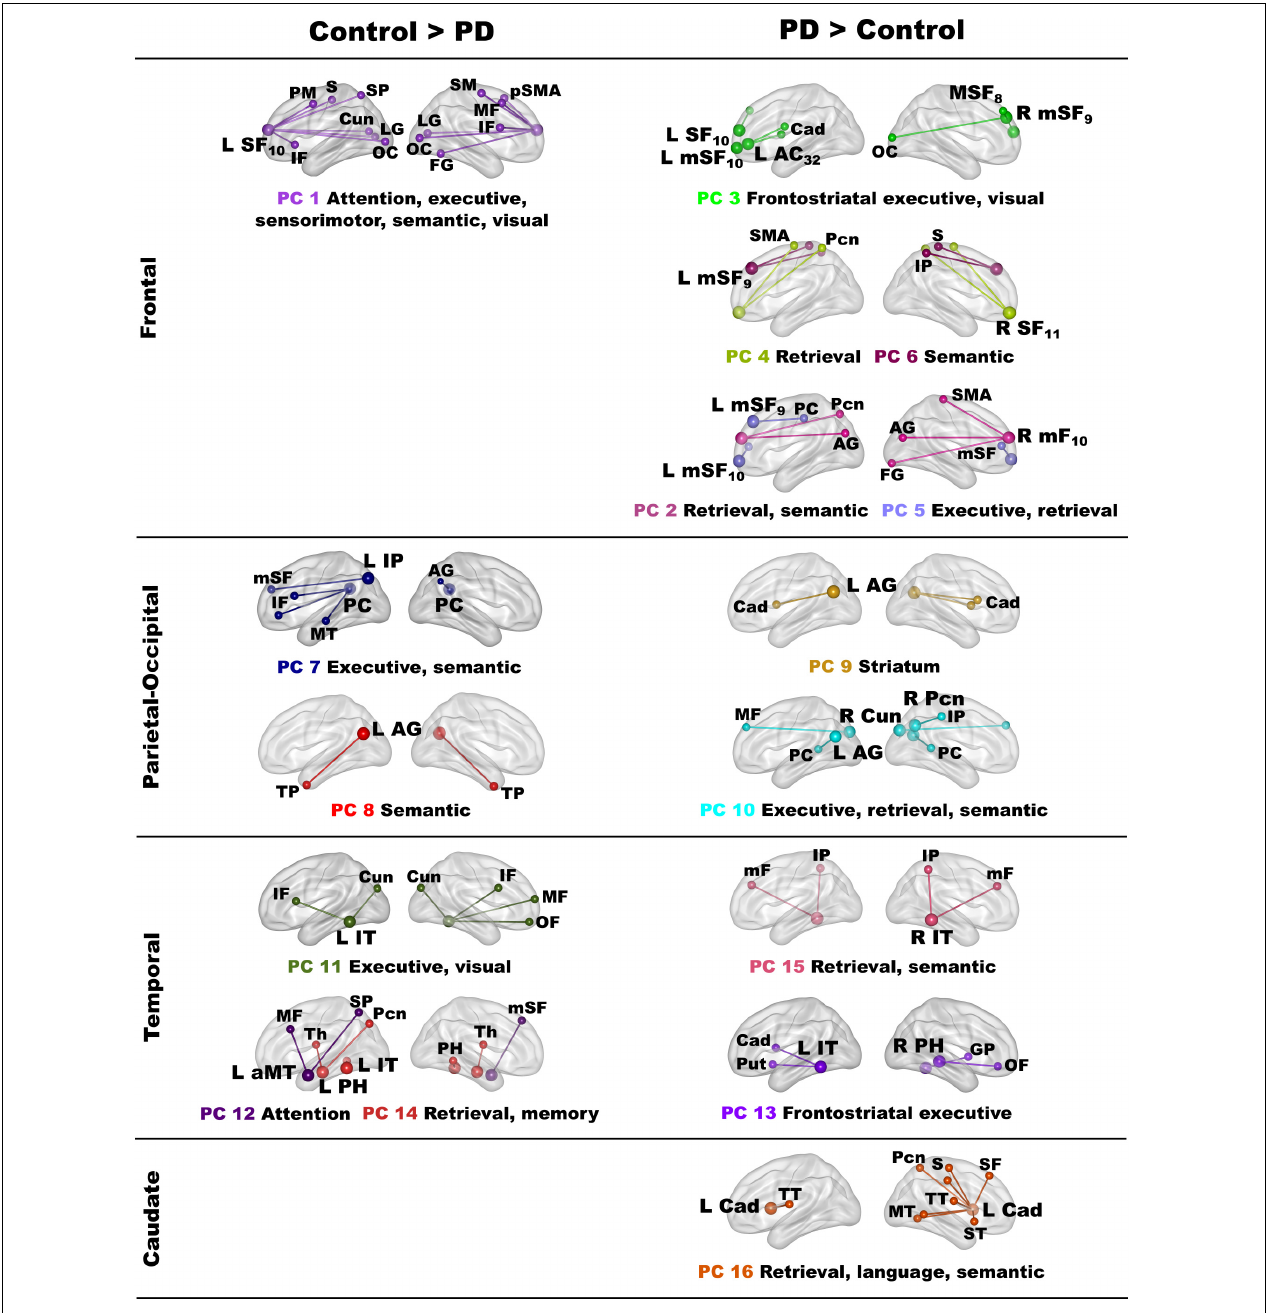
FIGURE 3 | Principal components derived from abnormal fame-modulated connections. Separate principal component analyses were conducted for connectivity features associated with frontal, parietal-cuneus, temporal, and subcortical seeds. The first and second columns respectively illustrate the principal components (PC) for which scores were greater in the control than the PD group (control features) and greater in the PD than the control group (PD features). For each PC, the seed(s) and their connection(s) (small balls) are color coded. The connection topology of a seed(s) are briefly described by their connectivity with regions engaged by executive, attention, retrieval, memory, semantic and language processing systems. Sagittal sections display connectivity features for the left (L) and right (R) hemispheres. Tables 3 , 4 detail the anatomy of features, matrix weights for each PC, and effect sizes from ANOVA tests for group differences in PC scores. Brodmann areas for frontal seeds are designated by subscripts. AC, anterior cingulate; AG, angular gyrus; aMT, anterior middle temporal; Cad, caudate; Cun, cuneus; FG, fusiform gyrus; IF, inferior frontal; GP, globus pallidus; IP, inferior parietal; IT, inferior temporal; LG, lingual gyrus; mF, medial frontal; mSF, medial superior frontal; MF, middle frontal; MT, middle temporal; OC, occipital cortex; OF, orbitofrontal; Pcn, precuneus; PC, posterior cingulate; PH, parahippocampus; PM, premotor; pSMA, presupplementary motor area; Put, putamen; S, sensory; SF, superior frontal; SM, sensorimotor; SMA, supplementary motor; SP, superior parietal; ST, superior temporal; Th, thalamus; TP, temporal pole; TT, transverse temporal.